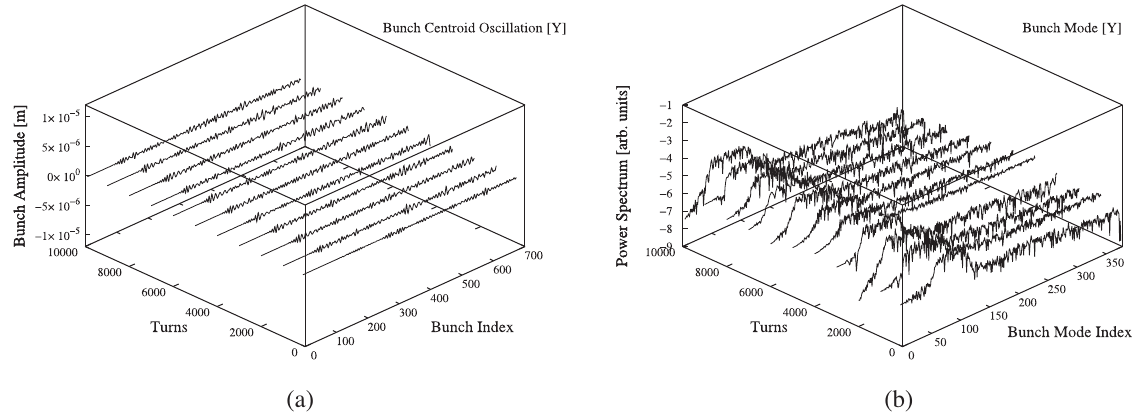
FIG. 11. Beam bunch oscillations in the vertical direction (left) and its frequency spectrum (right) as a function of the passing turns; both the synchrotron radiation damping and bunch-by-bunch FIR feedback system are taken into account. The beam current is 10 mA, and the weak-strong model is used in the